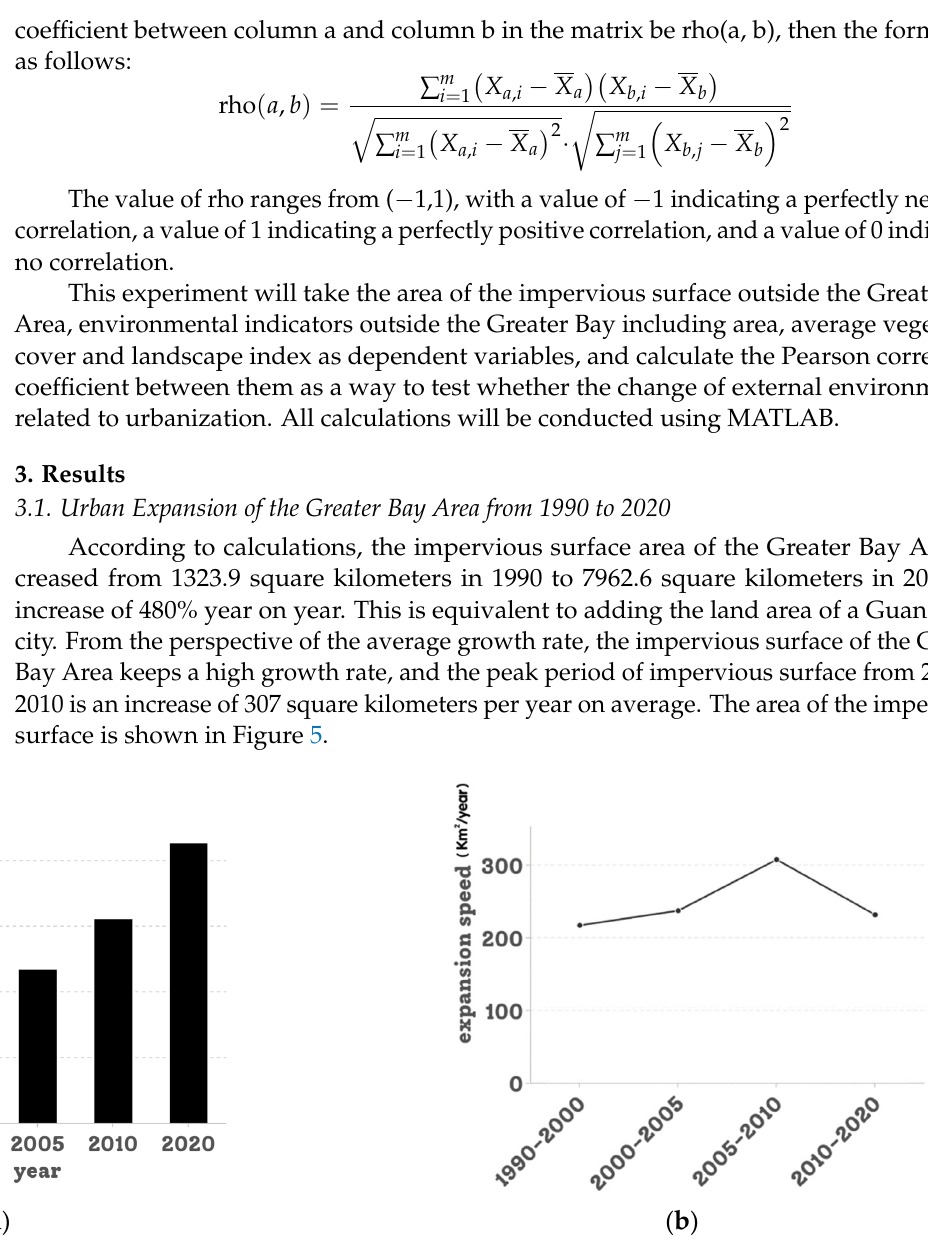
Figure 5. The expansion of impervious surface in the Greater Bay Area ( a ) The impervious surface area of the Greater Bay Area varies with the year ( b ) The growth rate of impervious water area in the Greater Bay Area in different years.